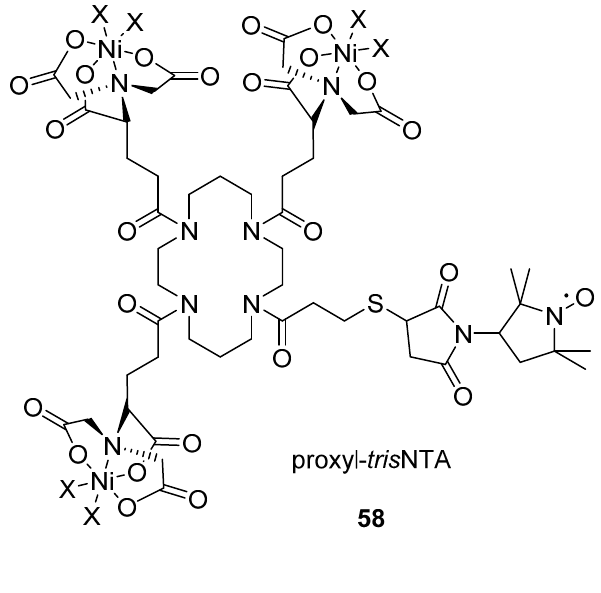
Figure 16. Histidine tag spin label proxyl- tris NTA 58 . X = histidine coordination